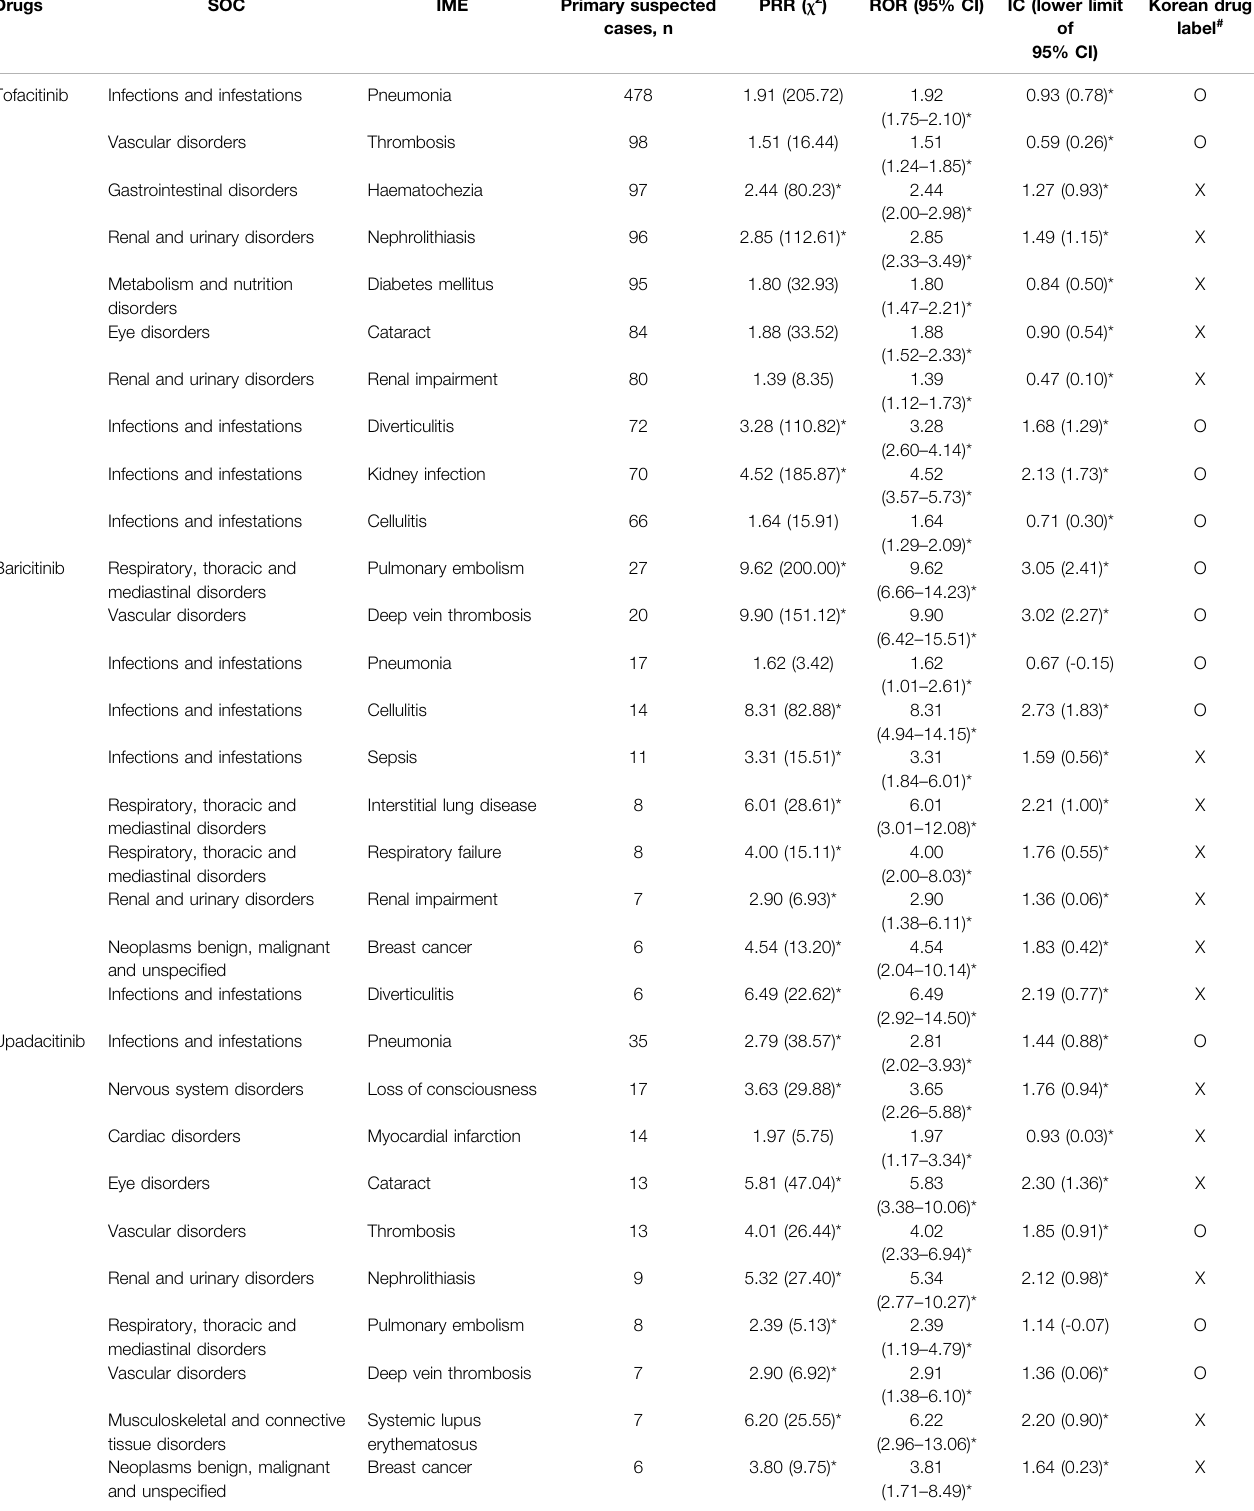
*Statistically signi fi cant association, i.e., the adverse events are detected as signals. # “ O ” means that the IME, is described in the Korean drug label, and “ X ” means not listed.